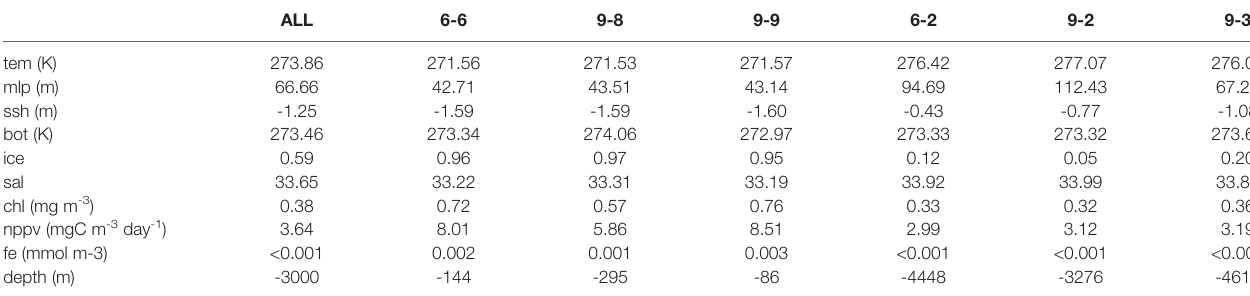
TABLE 2 | Mean values of variables at different bioregions.